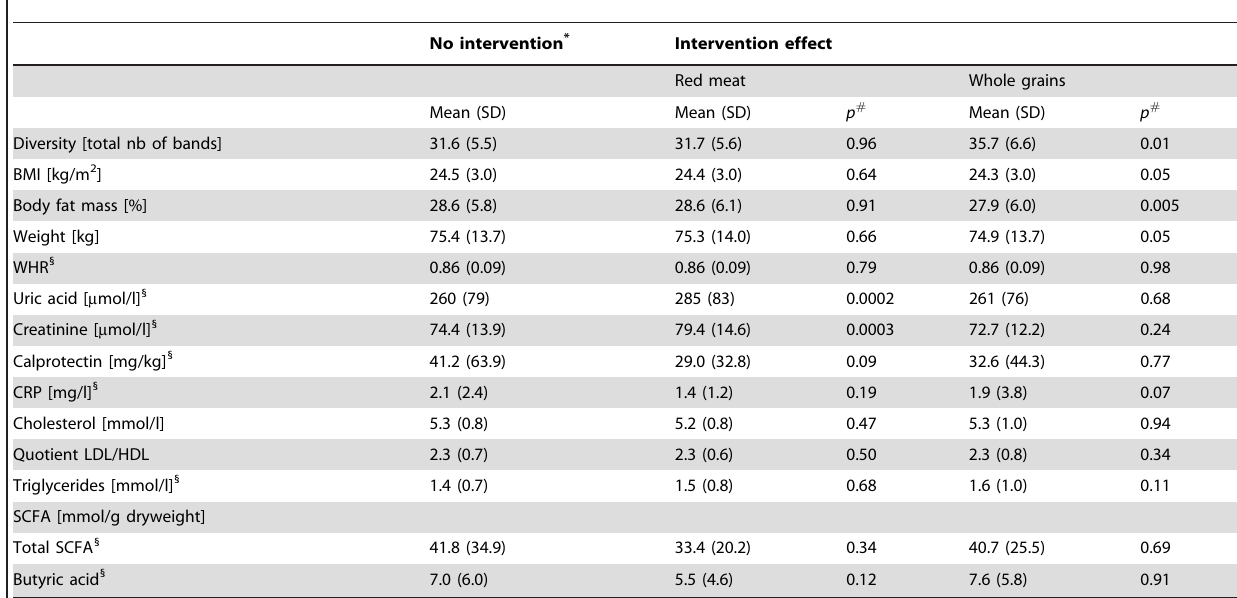
Table 2. Intervention effects on selected parameters from mixed effect models.